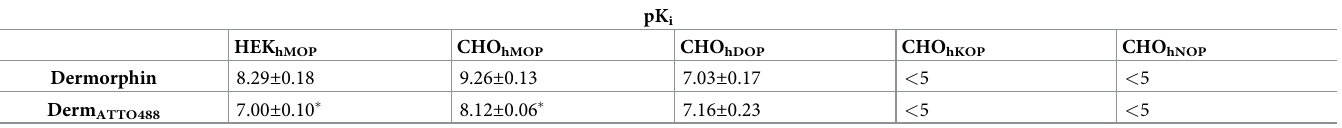
Table 1. Radioligand binding data.